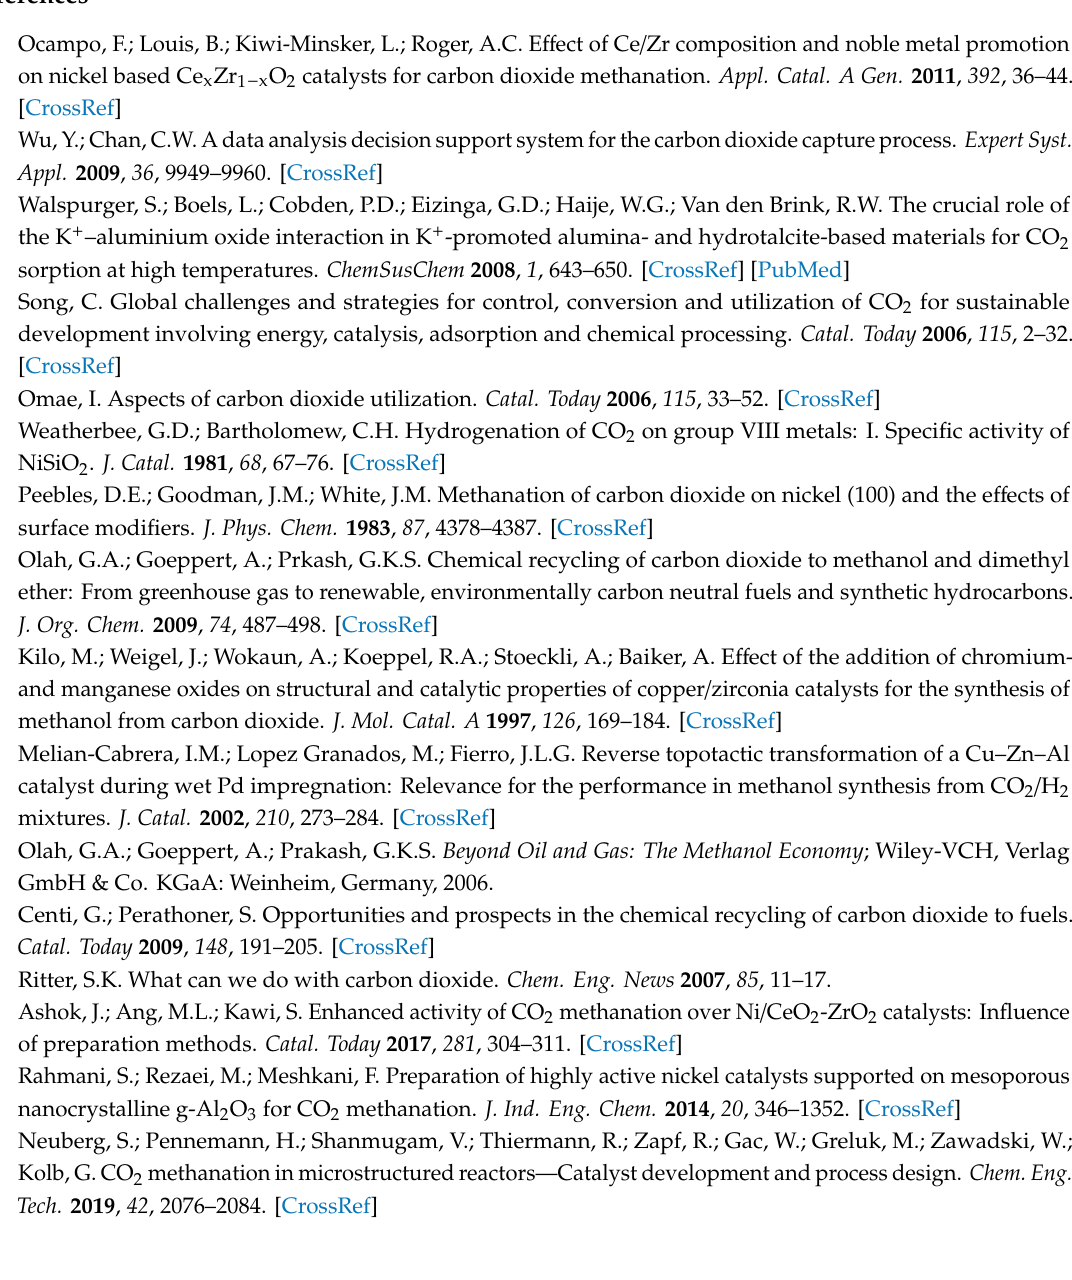
Figure S1: TEM image of Ni / CeO 2 catalysts and Figure S2. TEM image of (A) Ni / CeO 2 -S and (B) Ni / CeO 2 -EG (C) Ni / CeO 2 -OA and (D) Ni / CeO 2 -EDTA